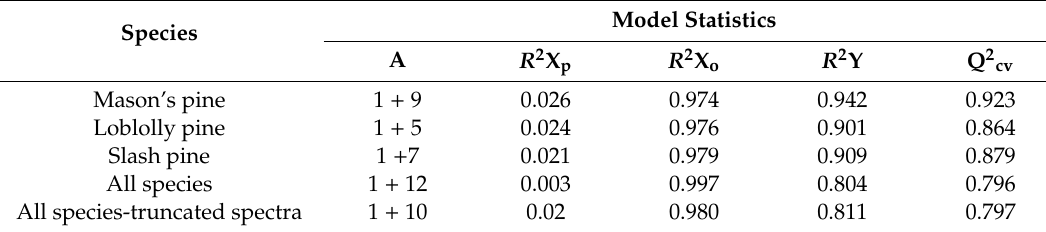
Table 2. Summary of model statistics for discriminant models developed to distinguish viable and dead-filled seeds of each pine species separately and all species combined using the entire NIR region (780–2500 nm) and truncated spectra (1870–1950 nm). Where A stands for number of significant predictive (the first values) and orthogonal (the second values) components to build the model; R 2 X p is the explained predictive spectral variation; R 2 X o = the explained Y-orthogonal variation that has no correlation to class discrimination; R 2 Y = the class variation explained by the model; and Q 2 cv = the predictive power of a model based on cross